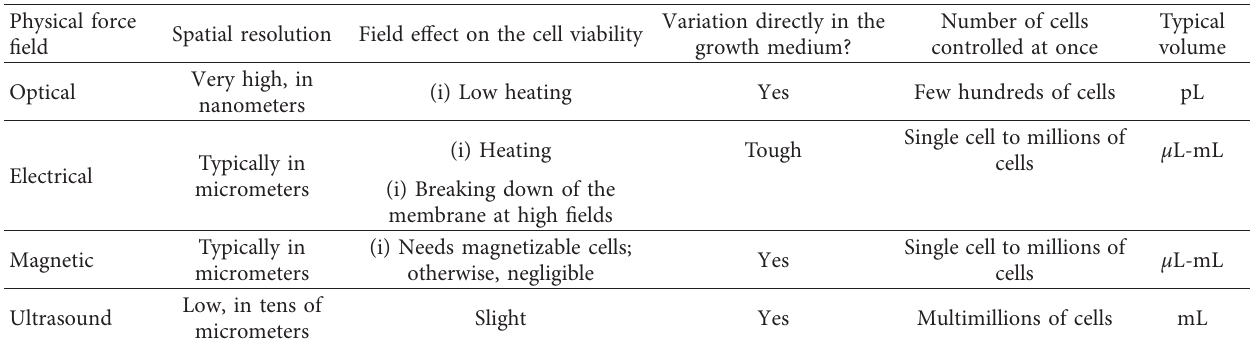
Table 4: Electric fields used for cell manipulation.